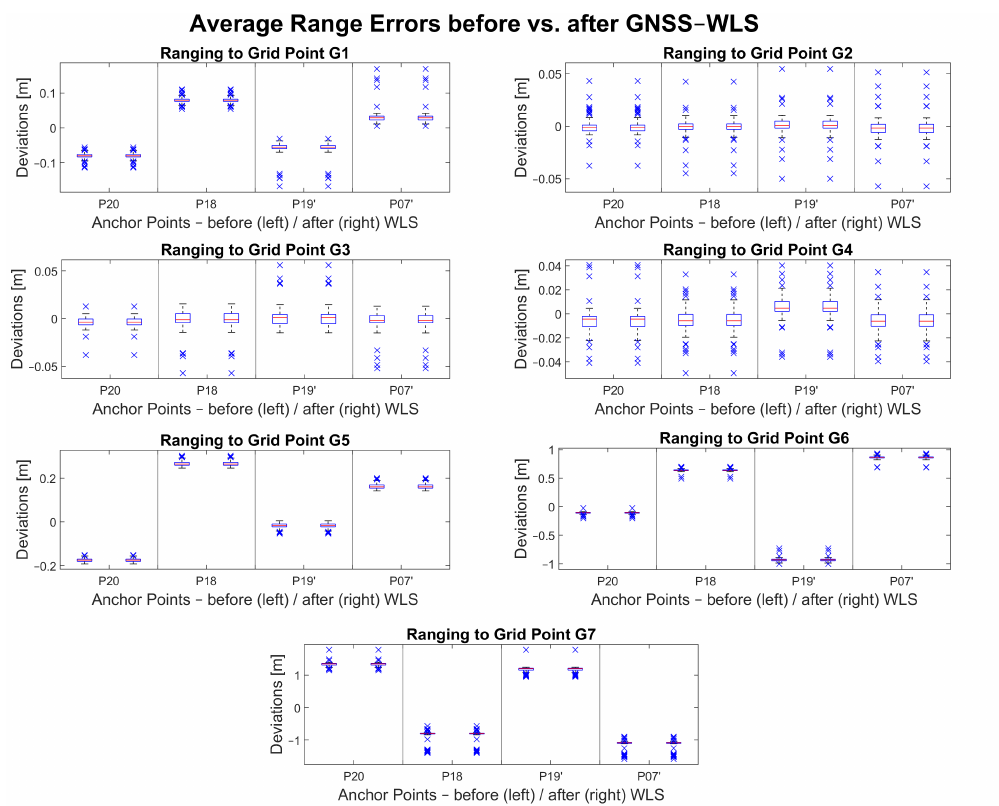
Figure 13. GNSS baseline errors before and after GNSS-only WLS